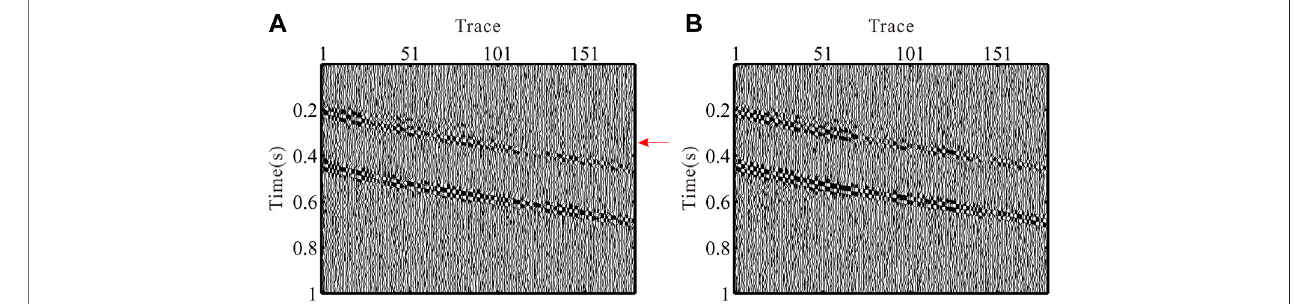
FIGURE 3 | Synthetic VSP data with noises and random geophone rotations. (A) X- and (B) Y-component.